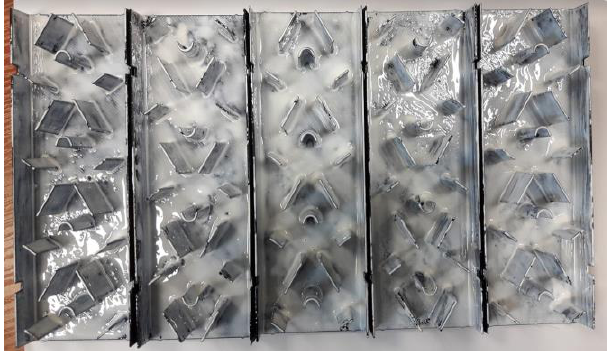
Fig. 3. Catalytic agent mixed with the adhesive